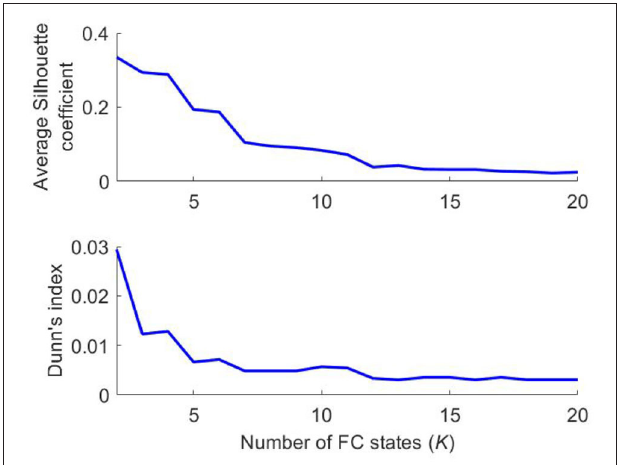
FIGURE 3 | Internal validation of K -means clustering results. Average Silhouette coefficient and Dunn’s index used to evaluate the quality of clustering